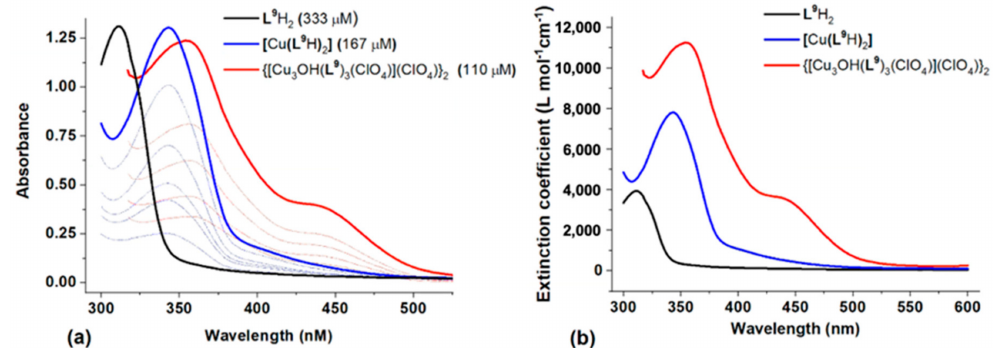
Figure 12. ( a ) The UV/Vis absorption spectra for varying concentrations of L 9 H 2 , [Cu(L 9 H) 2 ] and {[Cu 3 OH(L 9 ) 3 (ClO 4 )](ClO 4 )} 2 and ( b ) their respective molar extinction coefficients, obtained by the absorbance vs. concentration plots form ( a ). The high solubility of {[Cu 3 OH( L 9 H) 3 (ClO 4 )](ClO 4 )} 2 .2H 2 O.2MeCN in most polar or- ganic solvents and in water and the facile separation the mononuclear complex [Cu( L 9 H) 2 ]